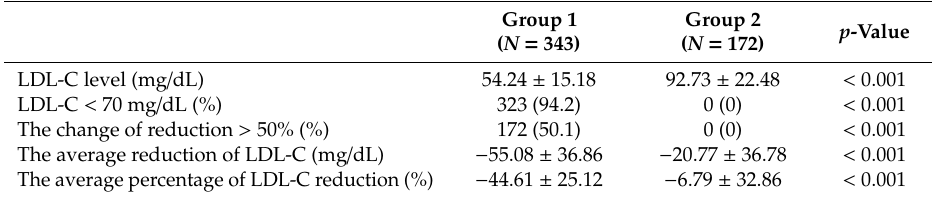
Table 4. The change in LDL-C levels of the study groups at one-year